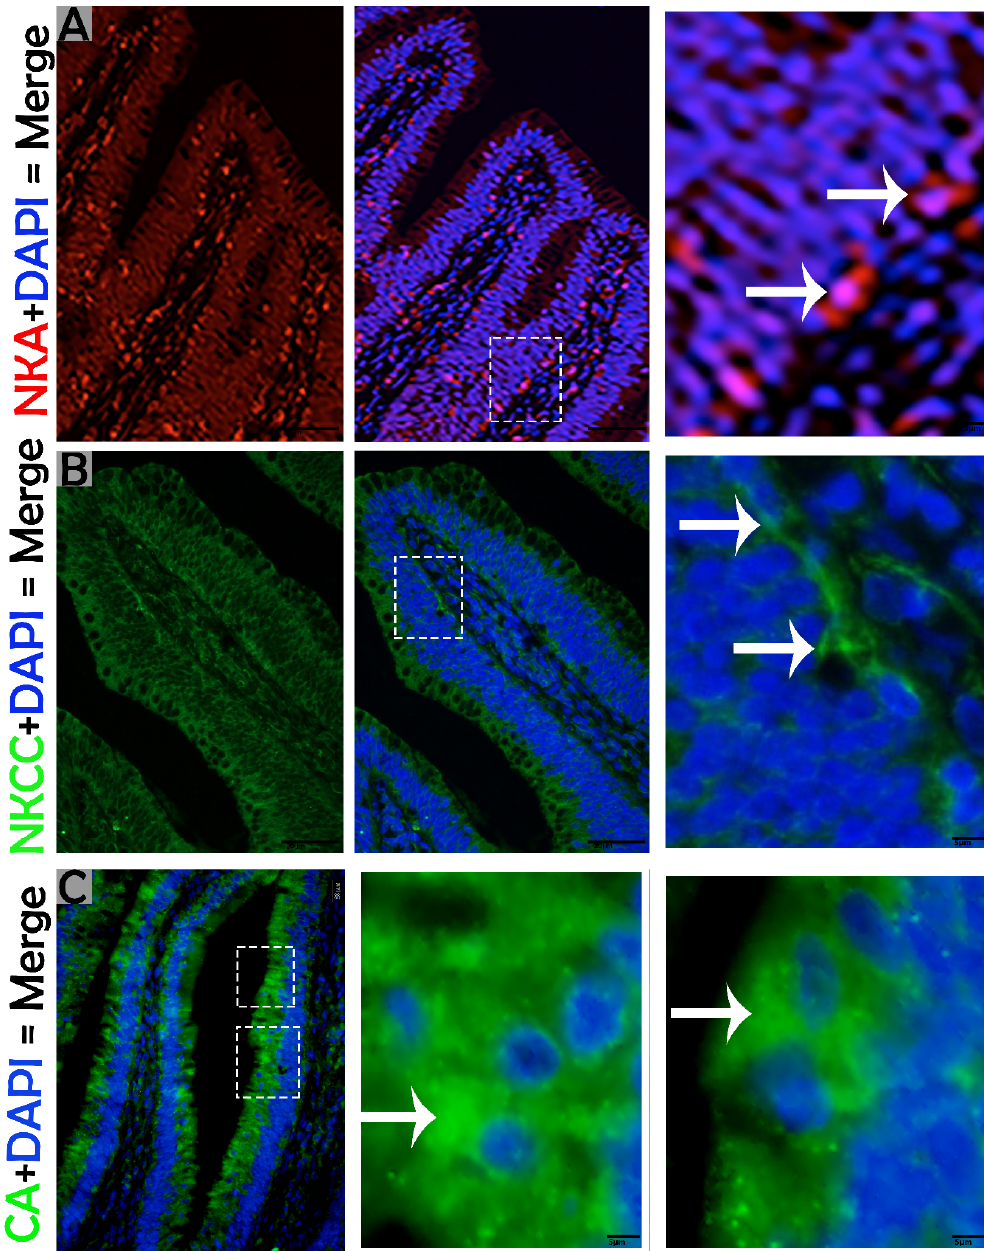
Figure 6. Immunofluorescence labeling of NKA, NKCC, and carbonic anhydrase (CA) in the small intestine of P. sinensis . The immunopositive localization of NKA, NKCC, and CA in the mucosal surface (white arrow). Scale bar = ( A – C ) 20